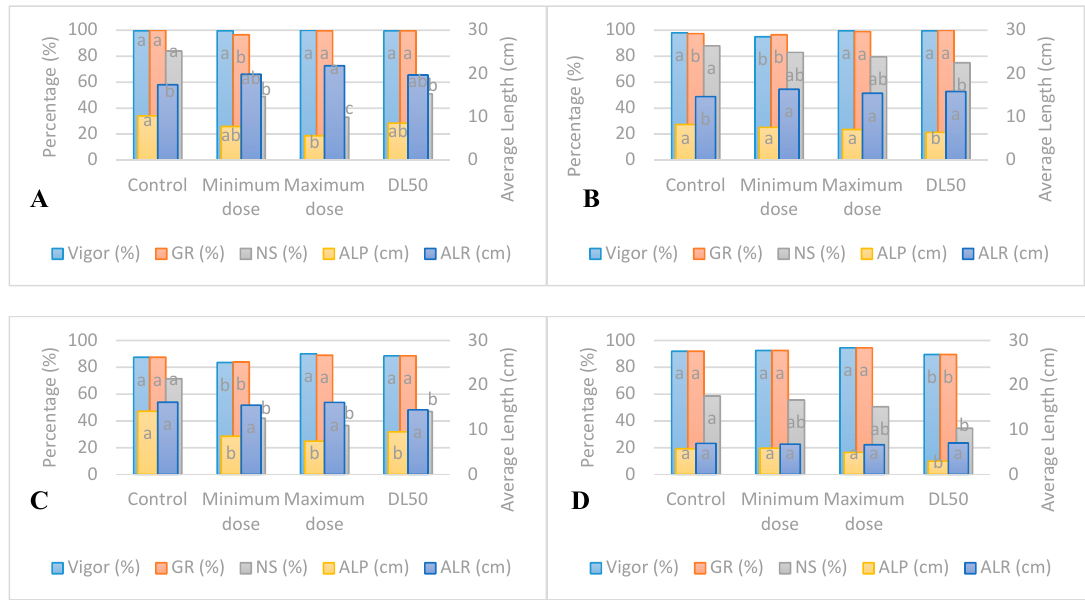
Figure 1. Standard germination tests in soy, wheat, sunflower and pine seedlings under UV-B radiation. ( A ). Glycine Max , ( B ). Triticum aestivum , ( C ). Helianthus annuus , ( D ). Pinus maximartinezii ; GR = Germination rate, NS = normal seedlings, ALP = average length of plumule, and ALR = average radicle length. Different letters in columns with the same color indicate significant differences ( p < 0.05).